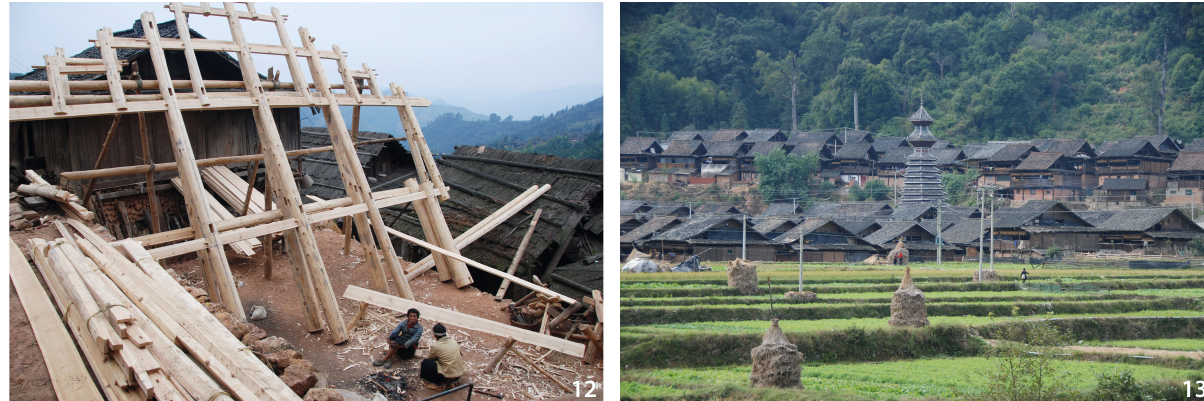
Figure 12 Wooden skeletons made by craftsmen in traditional Basha way (Source: the author). Figure 13 Dong village in Congjiang, Guizhou Province (Source: the